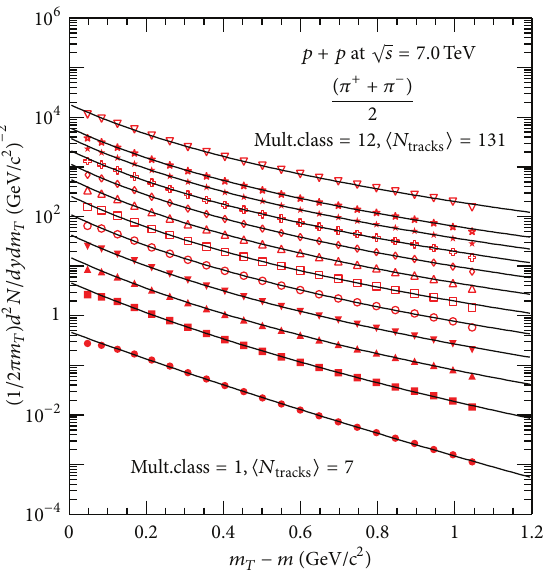
Figure7:Theinvariantyieldspectraof (𝜋 + +𝜋 − )/2 [21],asafunction of 𝑚 𝑇 − 𝑚 for 𝑝 + 𝑝 collisions at √𝑠 = 7.00 TeV. The yields are ⟩ 7, 16, 28, 40, 52, 63, 75, 86, 98, 109, 120, and shown for ⟨𝑁 tracks 131. The spectra are scaled up for clarity by a factor of 3 𝑖 , where 𝑖 = 0, 1, 2,3, 4, 5, 6,7, 8, 9,10 , and 11. The solid lines show the Tsallis